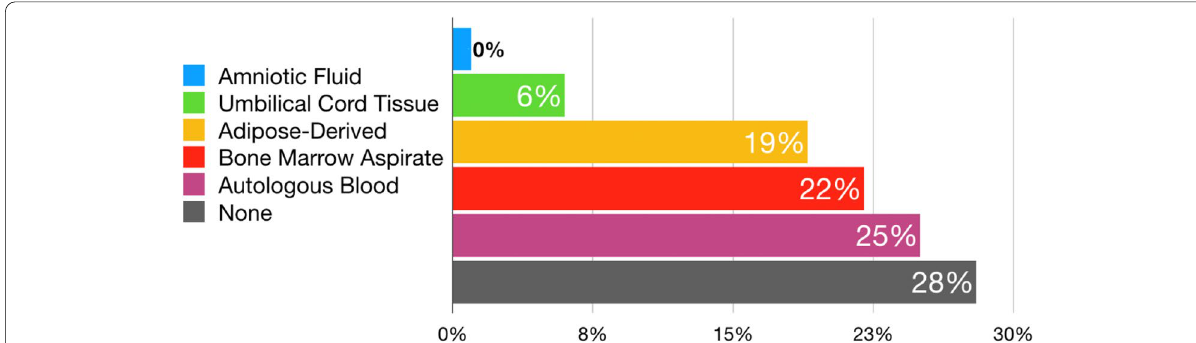
Fig. 1 Type of biologics reported as currently ‘most valuable’ for meniscus